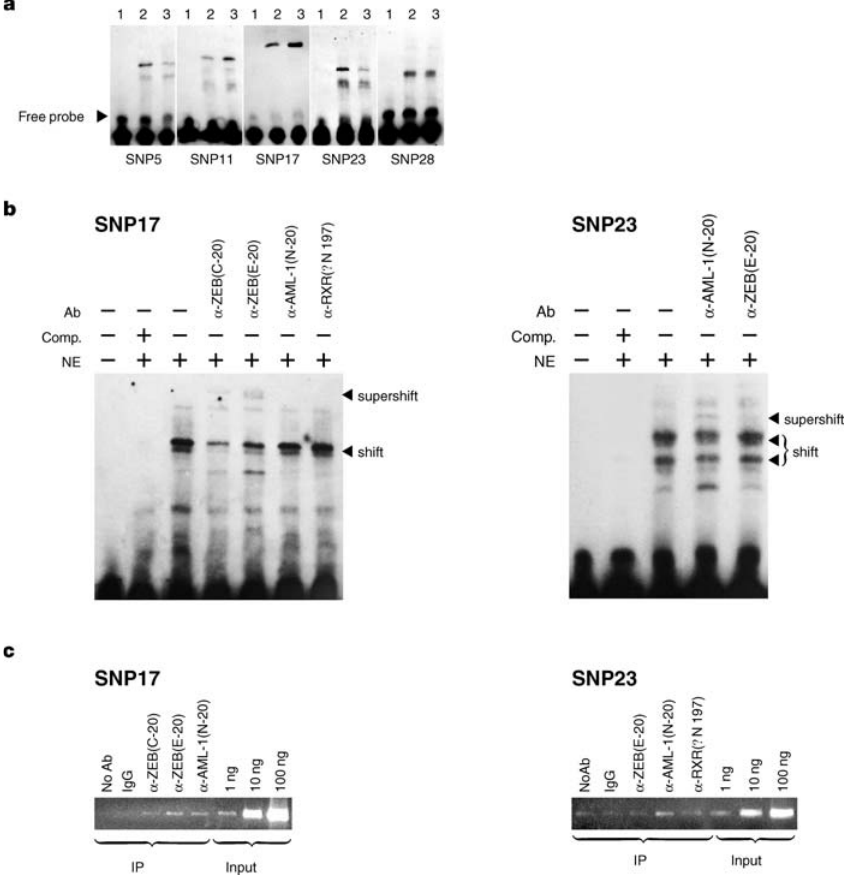
Figure 2. DNA-Protein Binding Studies (A) EMSA analyses for SNPs 5, 11, 17, 23 and 28. Lane 1 shows the high-expressing oligonucleotide incubated without nuclear extract. Lanes 2 and 3 show the high- and low-expressing SNP allele oligonucleotides, respectively, incubated with nuclear extract. (B) Competitor studies and antibody-mediated supershift assays. Biotin-labeled oligonucleotides corresponding to the 25-bp sequences immediately surrounding SNPs 17 and 23 were incubated with ( þ ) or without ( (cid:2) ) nuclear extract (NE), 100-fold excess unlabeled oligonucleotide competitor (Comp.), and the specific antibodies (Ab) indicated. (C) PCR assays with primer pairs specific for the SNP17 and SNP23 intervals and DNA that was immunoprecipitated with antibodies against ZEB and AML-1 or mock immunoprecipitated without antibody (No Ab), with anti-rabbit IgG only, or with antibody against retinoid X receptor (RXR). Positive controls consisting of 1 ng, 10 ng, and 100 ng of whole lysate DNA were amplified in